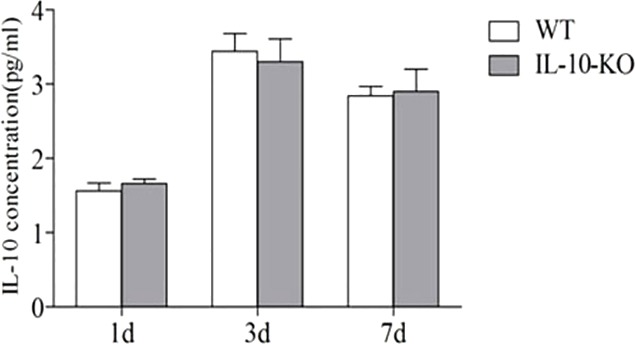
Adoptive transfer of Treg cells rescues IL10 production in Il10−/− mice after renal IR injury. C57BL/6 mice underwent IR by unilateral renal pedicle clamping for 45 min, followed by reperfusion (WT). Treg cells were isolated and purified from spleens of C57BL/6 mice, and then injected intravenously into Il10−/− mice (IL-10-KO) at 18 h before IR induction. The level of IL10 in Il10−/− was comparable with the kidneys in WT-IR on days 1, 3 and 7. Data are presented as mean±s.d. (n=6 mice). There was no significant difference in IL10 levels between wild type and Il10−/− mice.